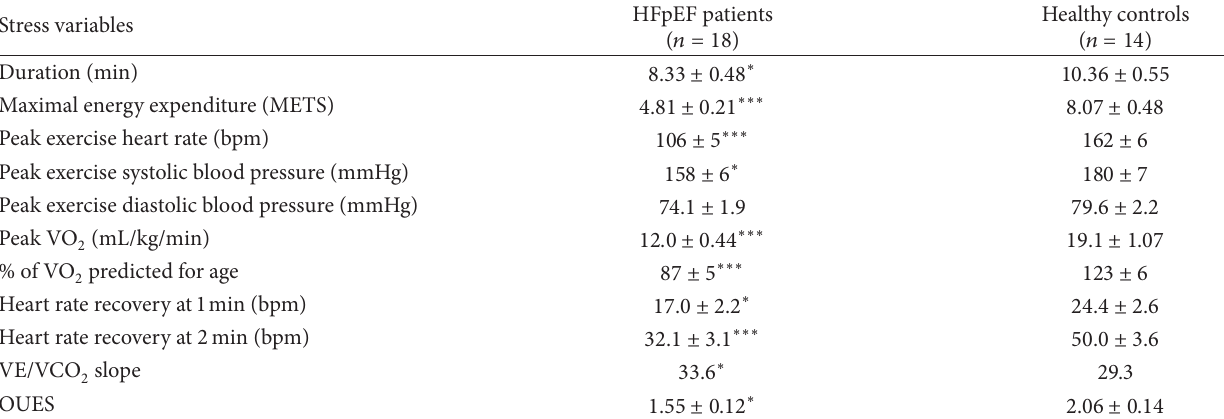
Table 2: Exercise haemodynamics and gas exchange parameters for the study population.